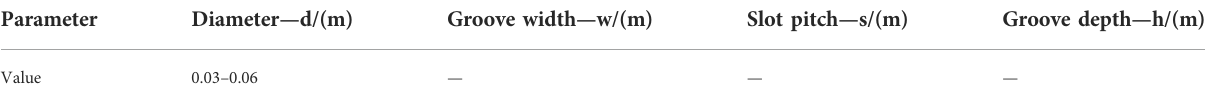
TABLE 1 Parameters of the BBHE ’ s structure. Parameter